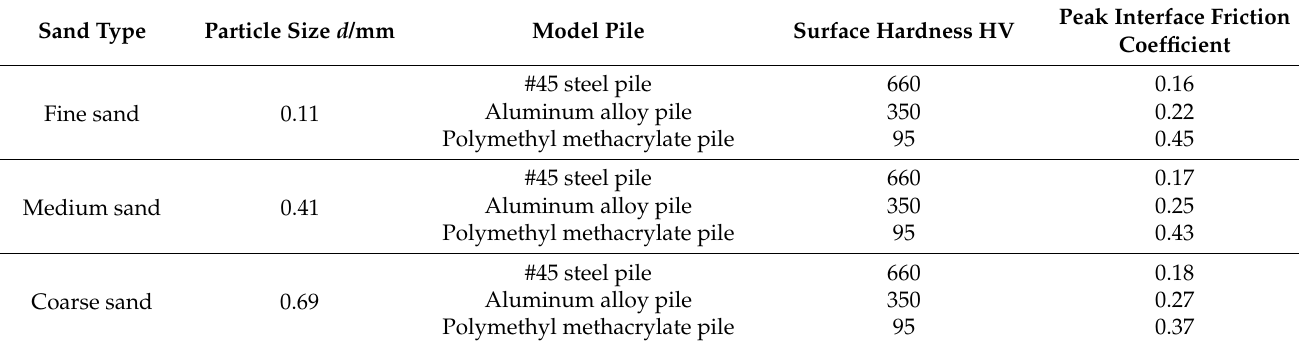
Table 4. List of the peak interface friction